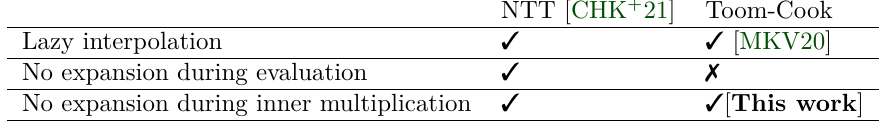
Table 1 Comparing features of multiplication based on FFT/NTT and Toom-Cook NTT [CHK + 21] Toom-Cook Lazy interpolation (cid:51) No expansion during